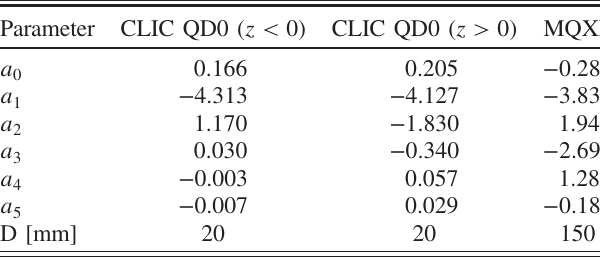
TABLE II. Parameters of the fringe field model.